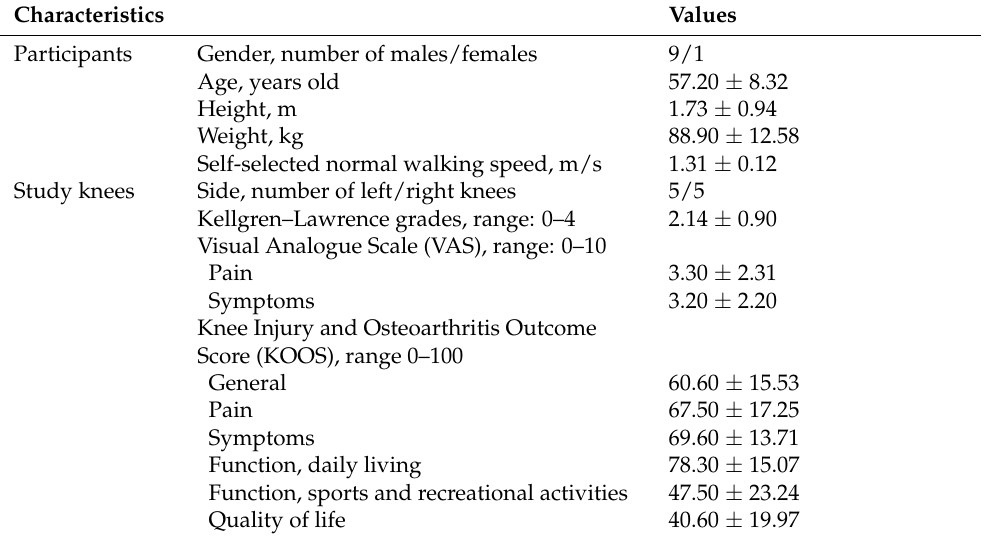
Table 1. Characteristics of the 10 participants and their study